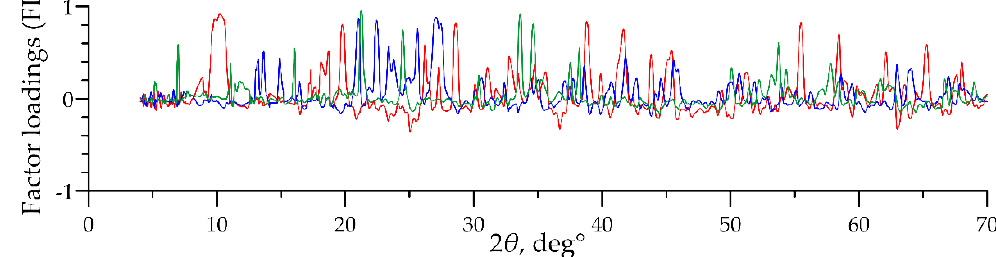
Figure 5. Examples of FL graphs of the most informative factors (red line — factor #5 “ alkaline amphibole ”; blue line— factor #9 “ orthoclase ”; green line— factor #12 “ monticellite ”) .